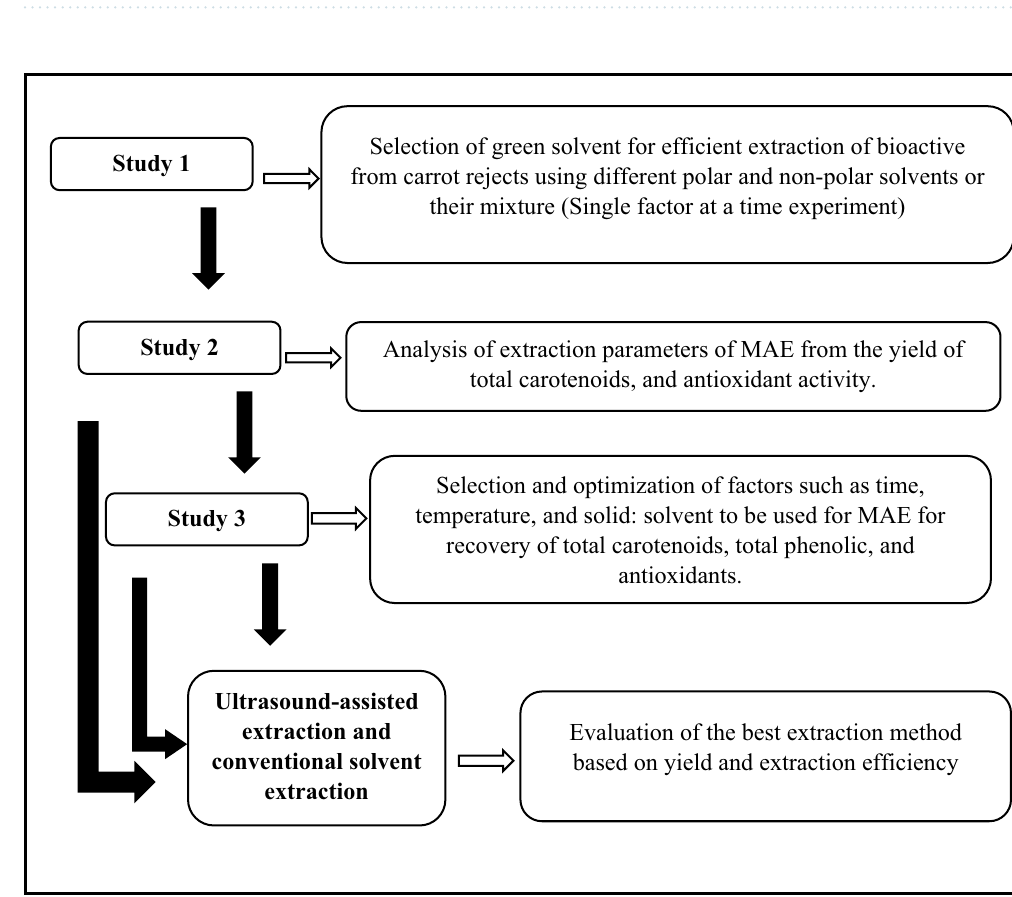
Table 1. Factors and levels used in the MAE experimental design of bioactive components from carrot rejects.